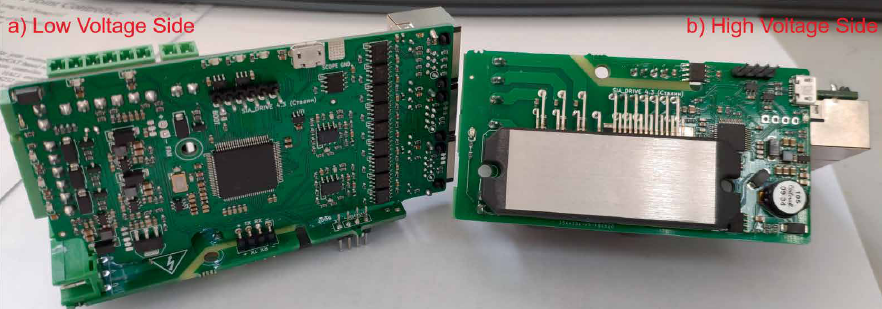
Figure 12: Joint motor driver. (a) The low voltage side; (b) the high voltage side.